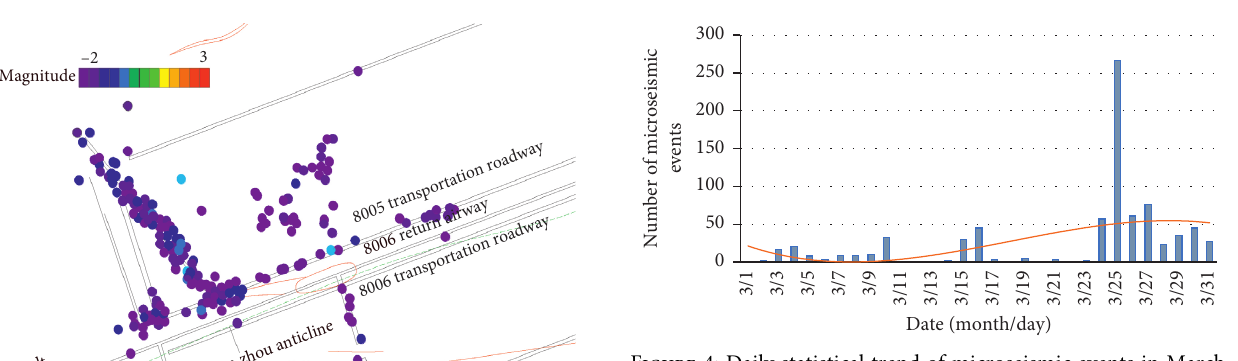
Figure 4: Daily statistical trend of microseismic events in